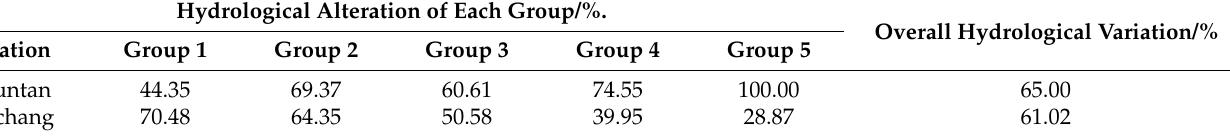
Table 5. Overall hydrological